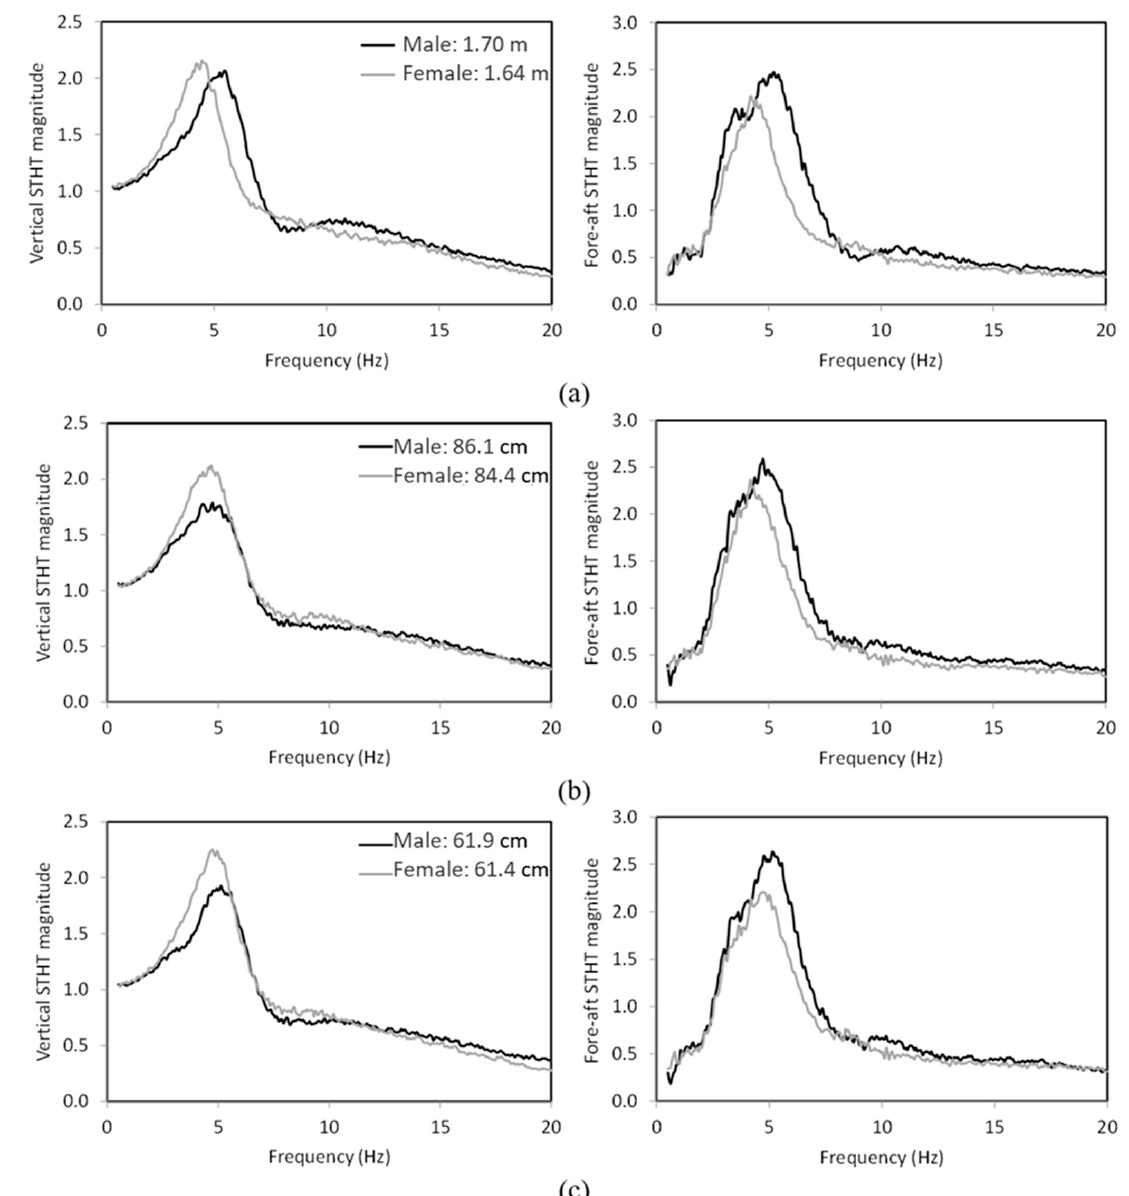
Figure 17. Effects of gender on mean vertical and fore-aft STHT magnitude responses considering comparable stature-related parameters of two gender groups: ( a ) stature; ( b ) sitting height; and ( c ) C7 height (NB support, 0.50 m/s 2 excitation).